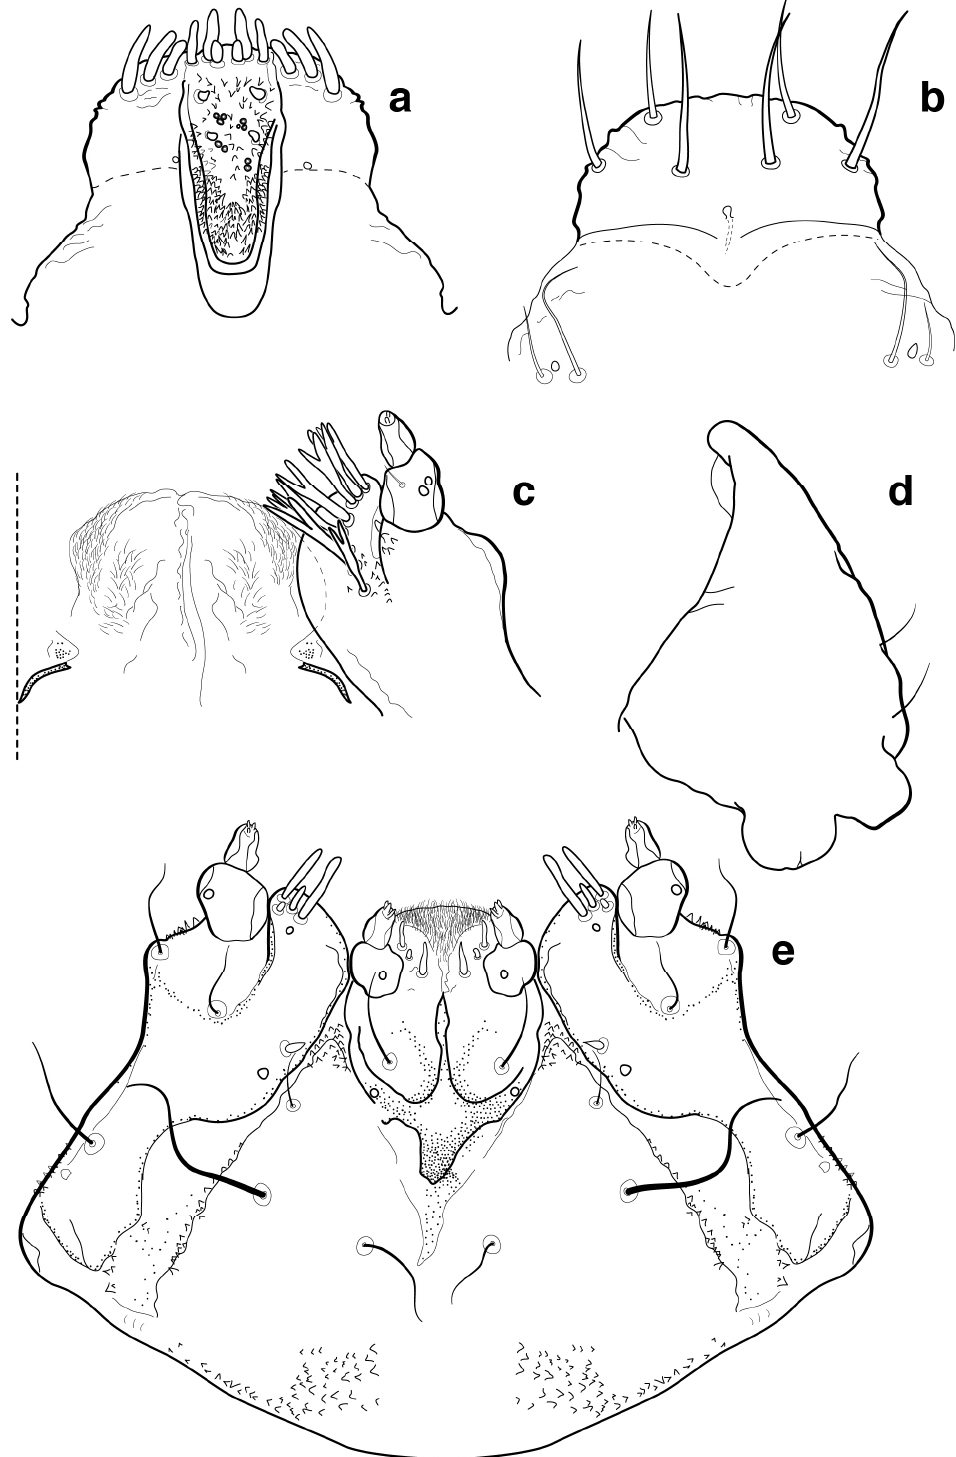
Figure 60. Diocalandra frumenti mouthparts: ( a ) epipharynx; ( b ) clypeus and labrum; ( c ) detail of hypopharynx, mala, and maxillary palp, dorsal view; ( d ) mandible; and ( e ) labio-maxillary complex, ventral view.